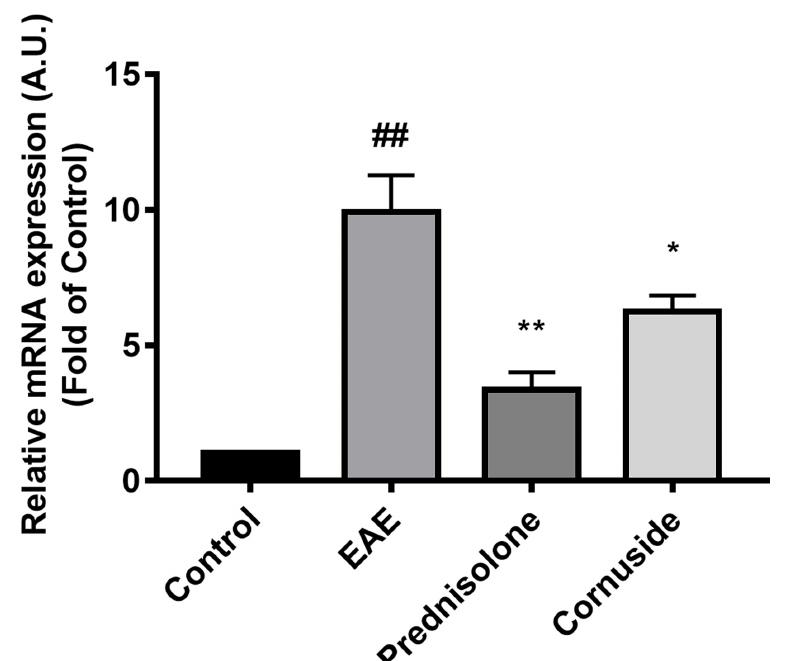
FIGURE 4 - Cornuside inhibited tumor necrosis factor-α (TNF-α) mRNA expression in the spinal cord (SC). SC TNF-α mRNA expressions were analyzed using real-time quantitative PCR, with 18s rRNA as the normalization standard. A.U. means arbitrary units. * P <0.05, ** P <0.01 for the cornuside or prednisolone group versus the EAE group, ## P <0.01 for the EAE group versus the control